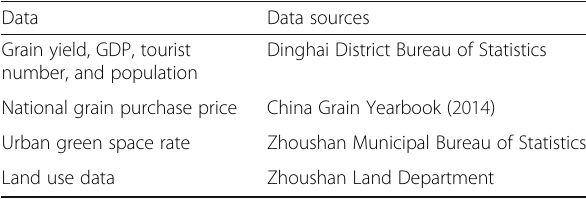
Table 1 Socioeconomic variables and data sources